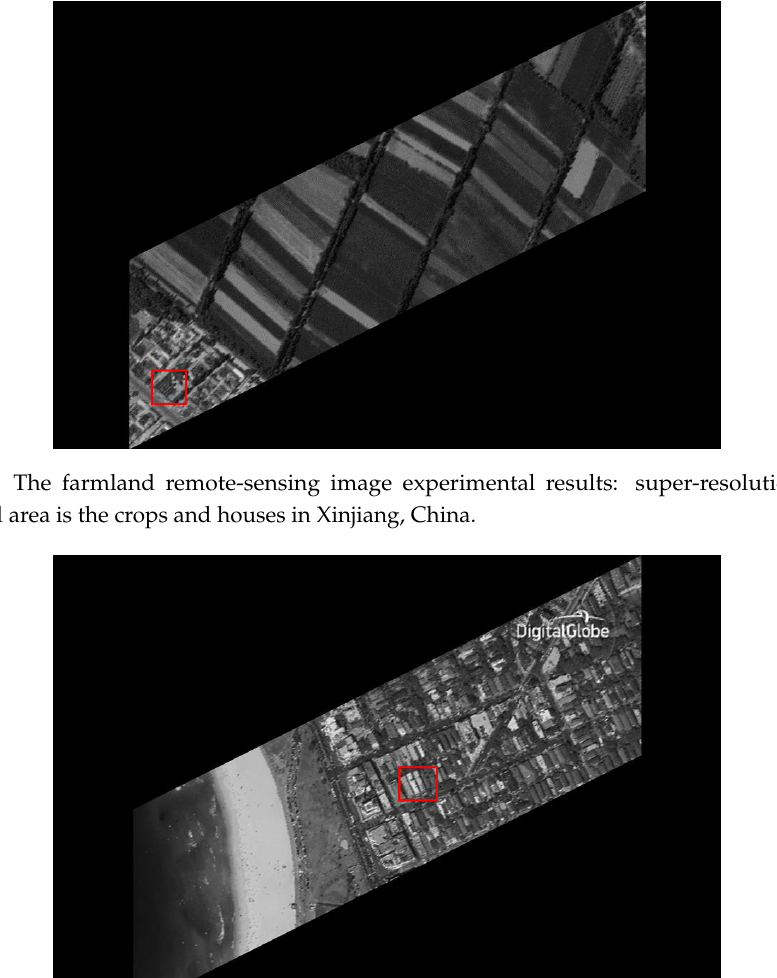
Figure 10. The seashore remote-sensing image experimental results: super-resolution images, the chosen area is an offshore structure in an Egyptian port.